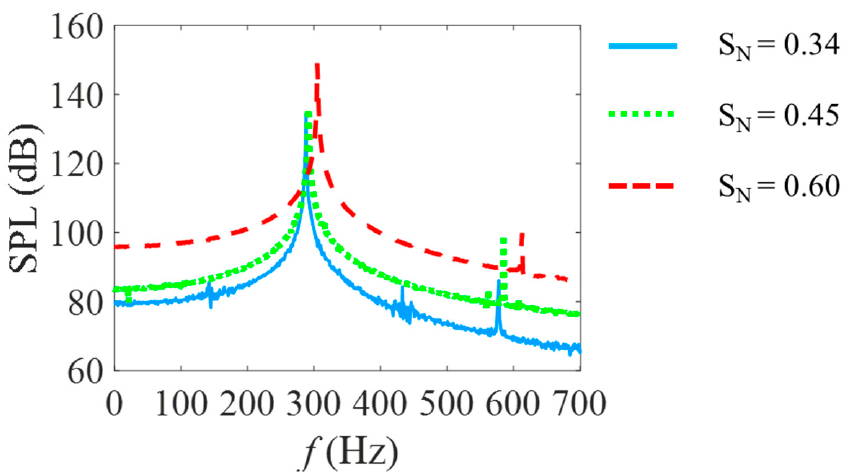
Figure 6. Frequency spectrum of acoustic pressure fluctuations of different S N at V a = 180 L/min and T i = 300 K.